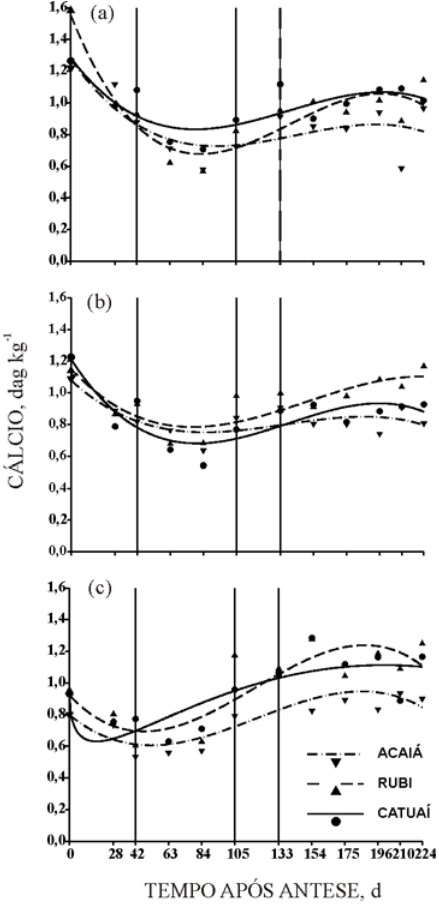
Figura 4. Concentração de cálcio em folhas de cafeeiro durante o período reprodutivo, nos níveis baixo (a), adequado (b) e alto (c) de adubação. As linhas verticais delimitam os estádios de desenvolvimento do fruto de chumbinho, expansão rápida, crescimento suspenso e granação-maturação.